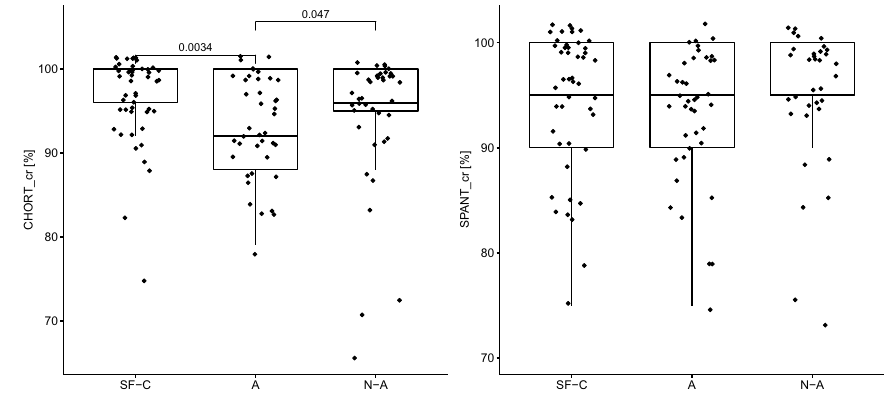
Figure 4. Choosing the correct answers for each